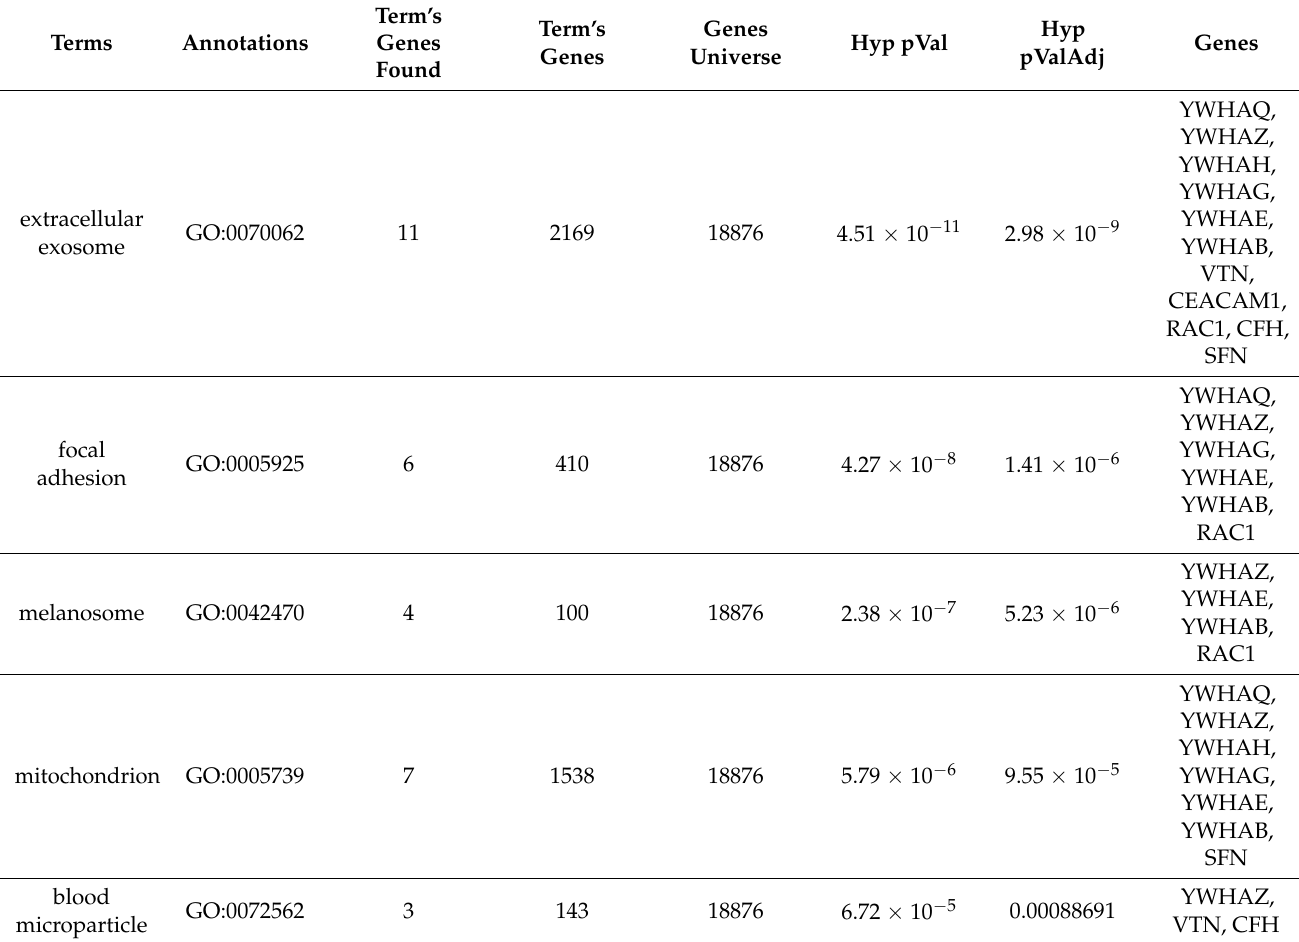
Table 7. The top 5 annotations identified by the GeneCodis FEA for CC